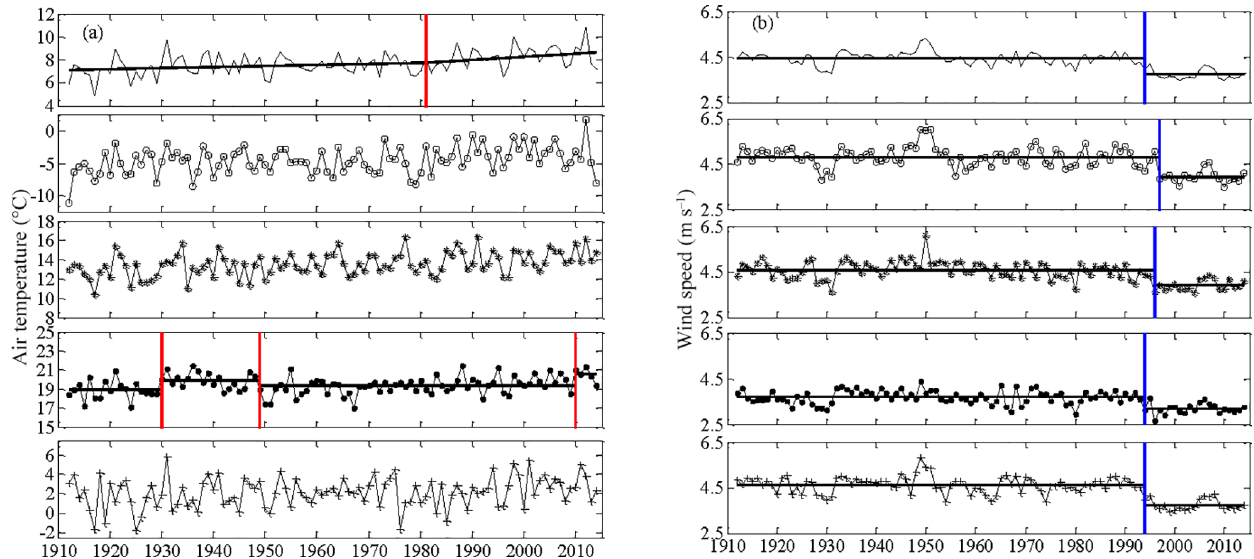
Figure 2. Yearly (solid lines), winter (open circles), spring (asterisks), summer (solid circles), and fall (crosses) (a) air temperature and (b) wind speeds for Madison, WI, USA. The red line in the yearly air temperature figure represents a breakpoint in the trend of av- erage air temperature increase from 0.081 to 0.334 ◦ Cdecade − 1 occurring in 1981. Red lines in the summer air temperature figure represent abrupt changes in average summer air temperature occurring in 1930, 1949, and 2010. Blue lines in the wind speed figures represent abrupt changes in yearly wind speed change in 1994, winter wind speed in 1997, spring wind speed in 1996, summer wind speed in 1994, and fall wind speed in 1994. Table 4. Trends and in-lake physical variables for the three studied lakes from 1911 to 2014. Trends are represented as unitsdecade − 1 . NA indicates data that are not available. Lake Mendota Fish Lake Lake